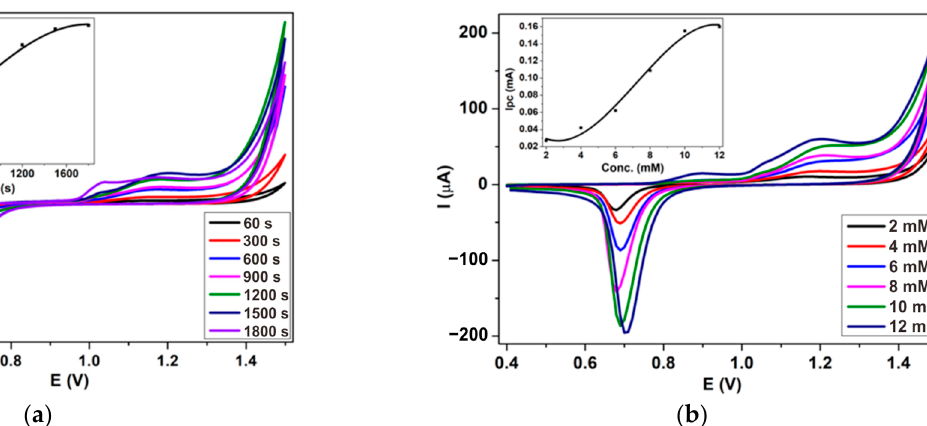
Figure 5. Cyclic voltammogram of AuNS-modified SPCE on the variation of ( a ) deposition time and ( b ) precursor concentration measured in 0.5 M H 2 SO 4 . The inset shows the correlation curve of the reduction peak current towards ( a ) deposition time and ( b ) precursor